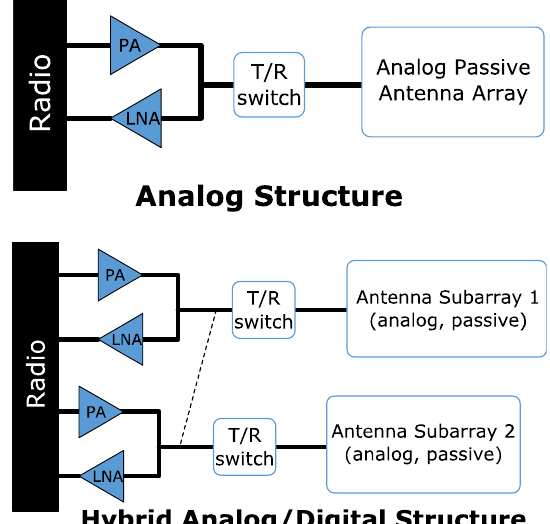
Figure 38. Single-beam ESA with a fully analog architecture for point-to-point communications